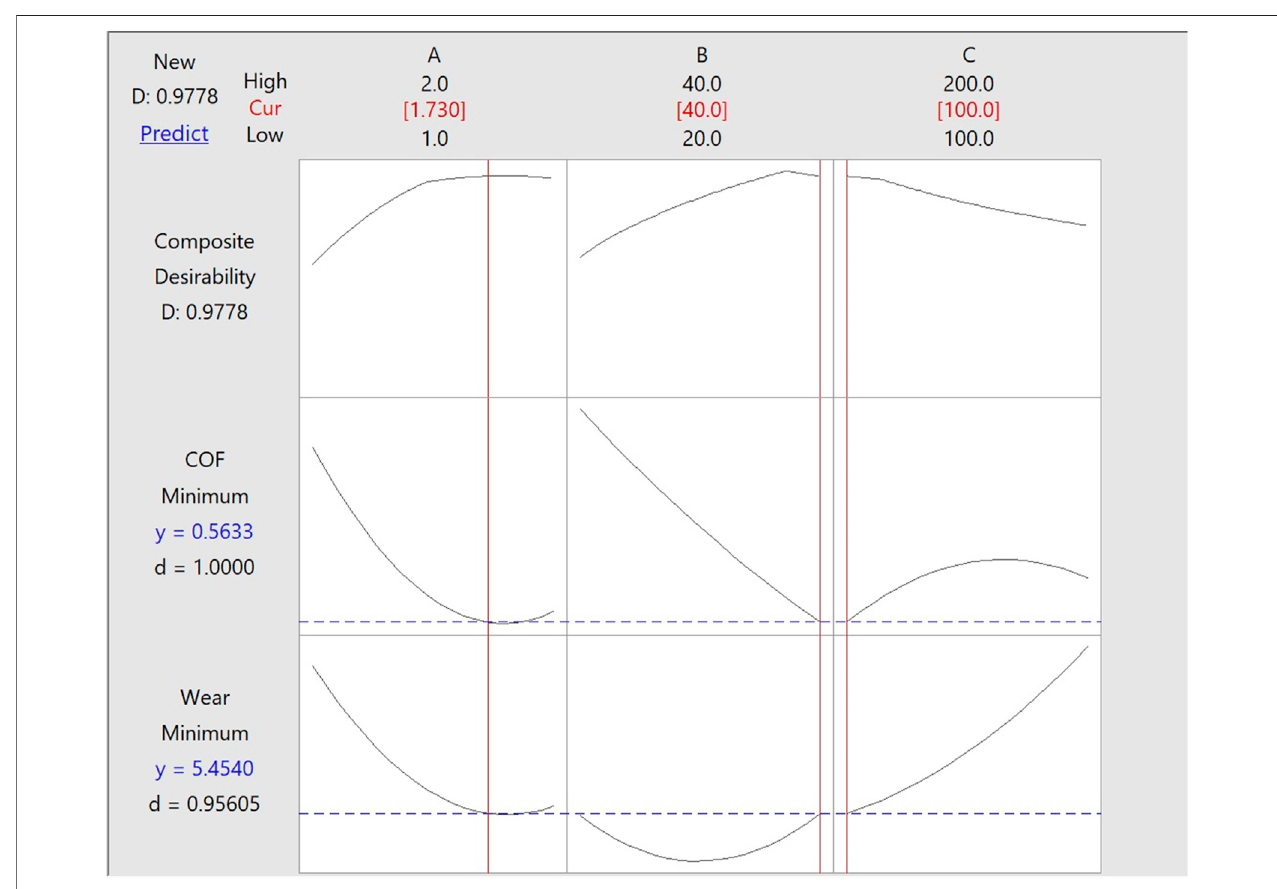
FIGURE 10 | Desirability plot for multi-objective optimization of wear rate and